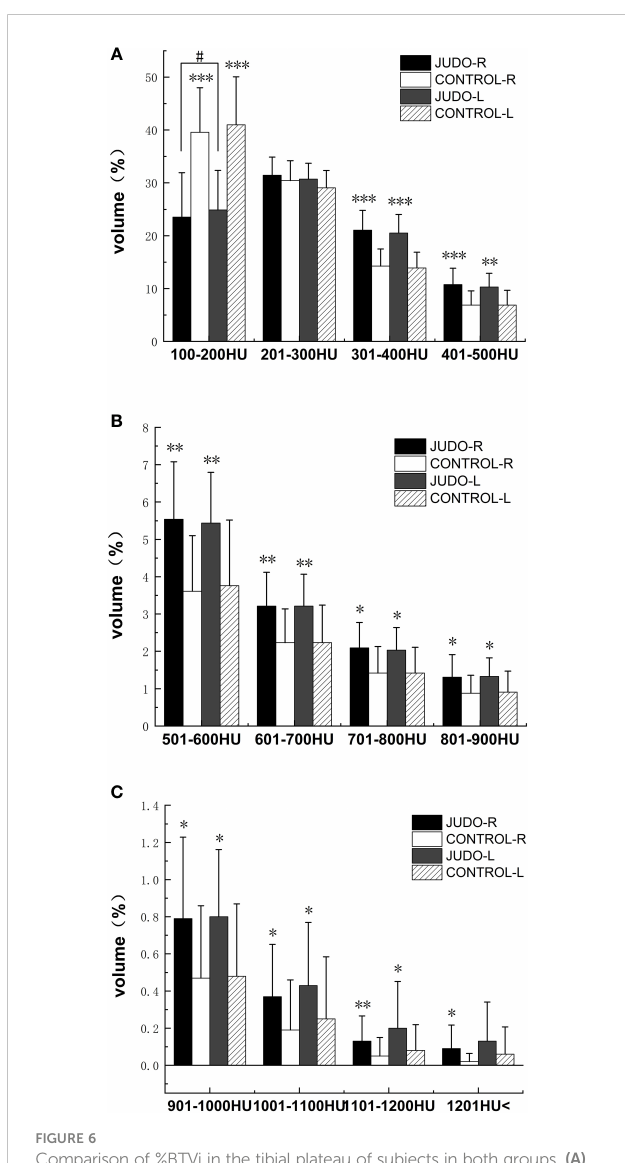
FIGURE 6 Comparison of %BTVi in the tibial plateau of subjects in both groups. (A) shows bone tissue volumes for low bone density in judo and control subjects; (B) shows bone tissue volumes for moderate bone density in judo and control subjects; (C) shows bone tissue volumes for high bone density in judo and control subjects (***, ** and * denote statistically signi fi cant P values < 0.001, < 0.01 and < 0.05 for control, respectively; # denotes P values for comparisons among judo athletes with statistical signi fi cance of < 0.05,